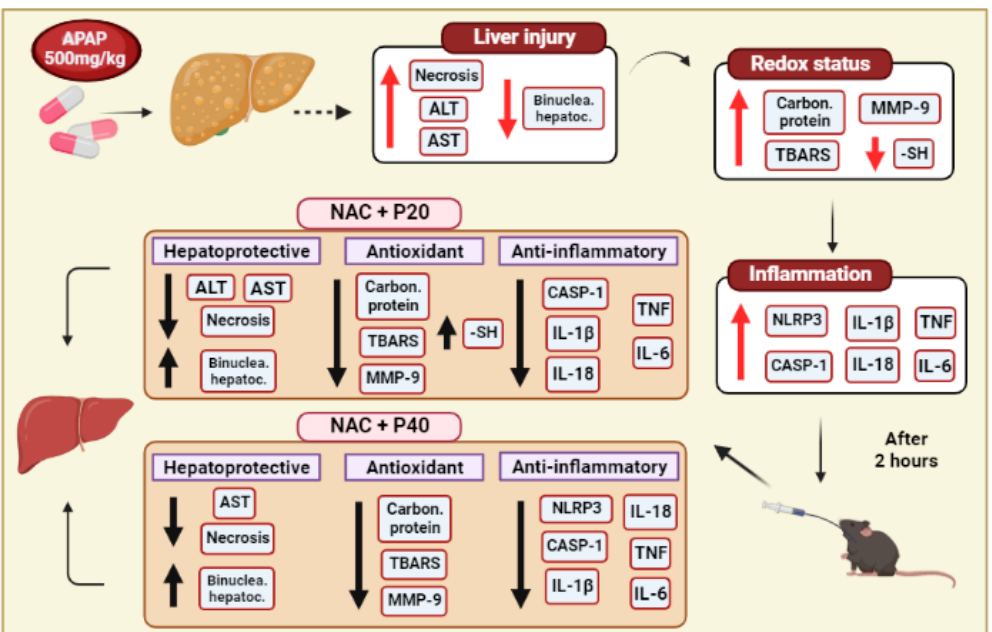
Figure 6. Representative drawing of the APAP-induced liver intoxication after 12 h and the treatments (NAC+P20 and NAC+P40). Paracetamol was administered at a dose of 500 mg/kg and the hepatic, histological, oxidative, and inflammatory changes are represented in the boxes and indicated with the red arrow. As treatment, we used piperine (P) associated or not associated with n-acetylcysteine (NAC) and the results are represented in the boxes and indicated with black arrow. Upward arrows indicate an increase and downward arrows indicate a decrease in the evaluated indexes. Abbreviations: paracetamol (APAP), N-acetylcysteine (NAC), piperine 20 mg/kg (P20), piperine 40 mg/kg (P40), alanine aminotransferase (ALT), aspartate aminotransferase (AST), carbonylated protein, thiobarbituric acid-reactive substances (TBARS), metalloproteinase-9 (MMP-9), sulfhydryl (-SH) group, caspase-1(casp-1), interleucina 1 beta (IL-1 β ), interleucina 18 (IL-18), interleucina 6 (IL-6), and tumor necrosis factor (TNF).